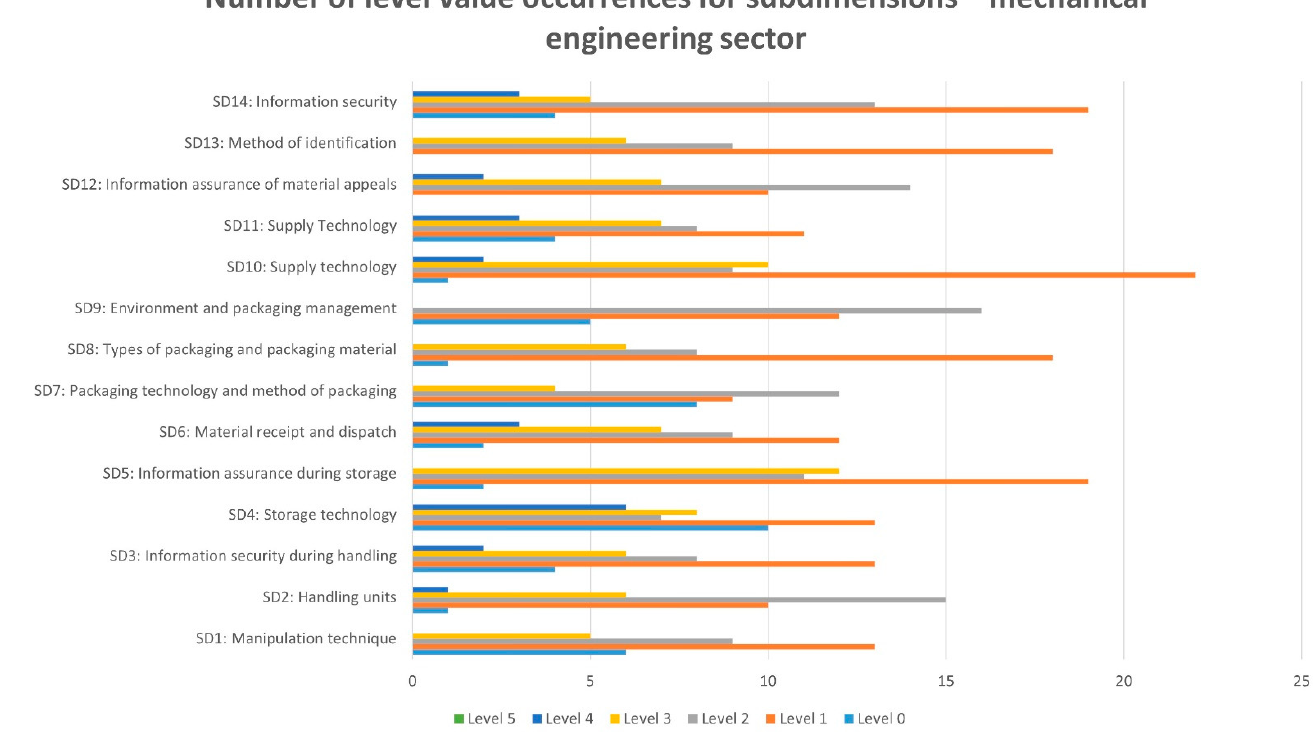
Figure 11. Total number of occurrences of values—mechanical engineering.